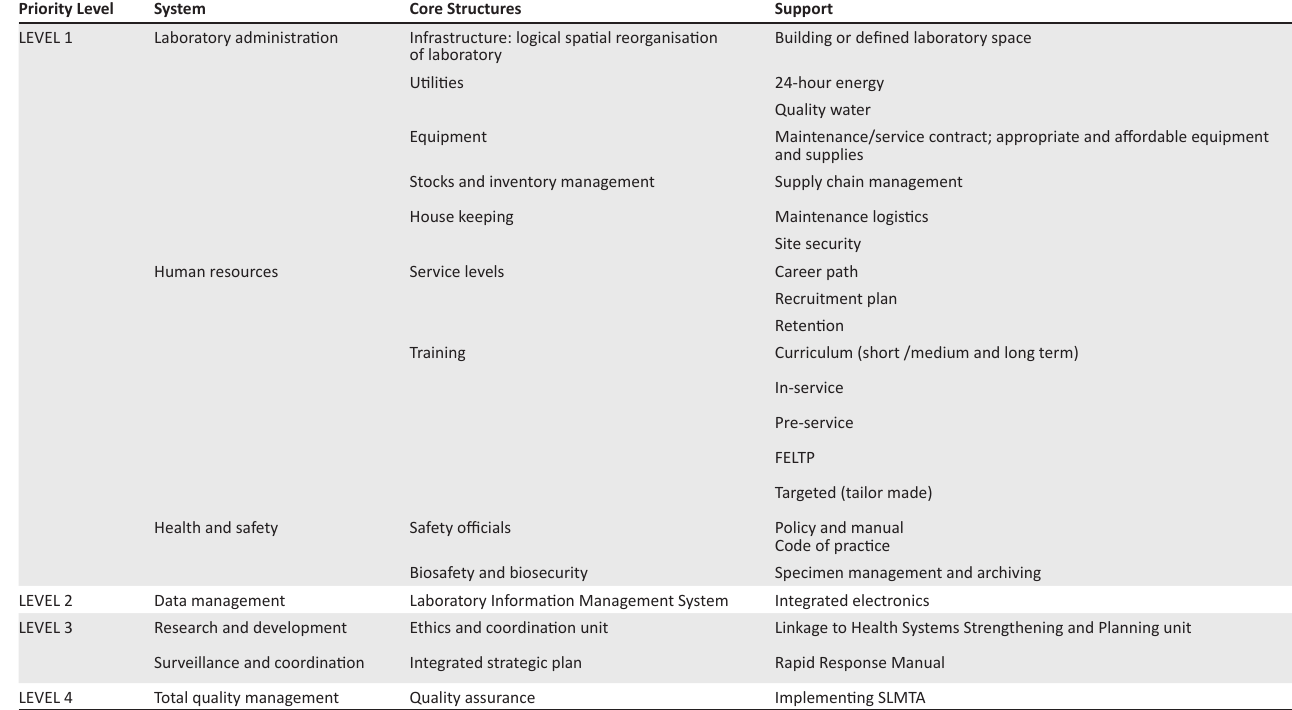
TABLE 1: Minimum laboratory standards and implementation priorities in Sierra Leone, 2016.